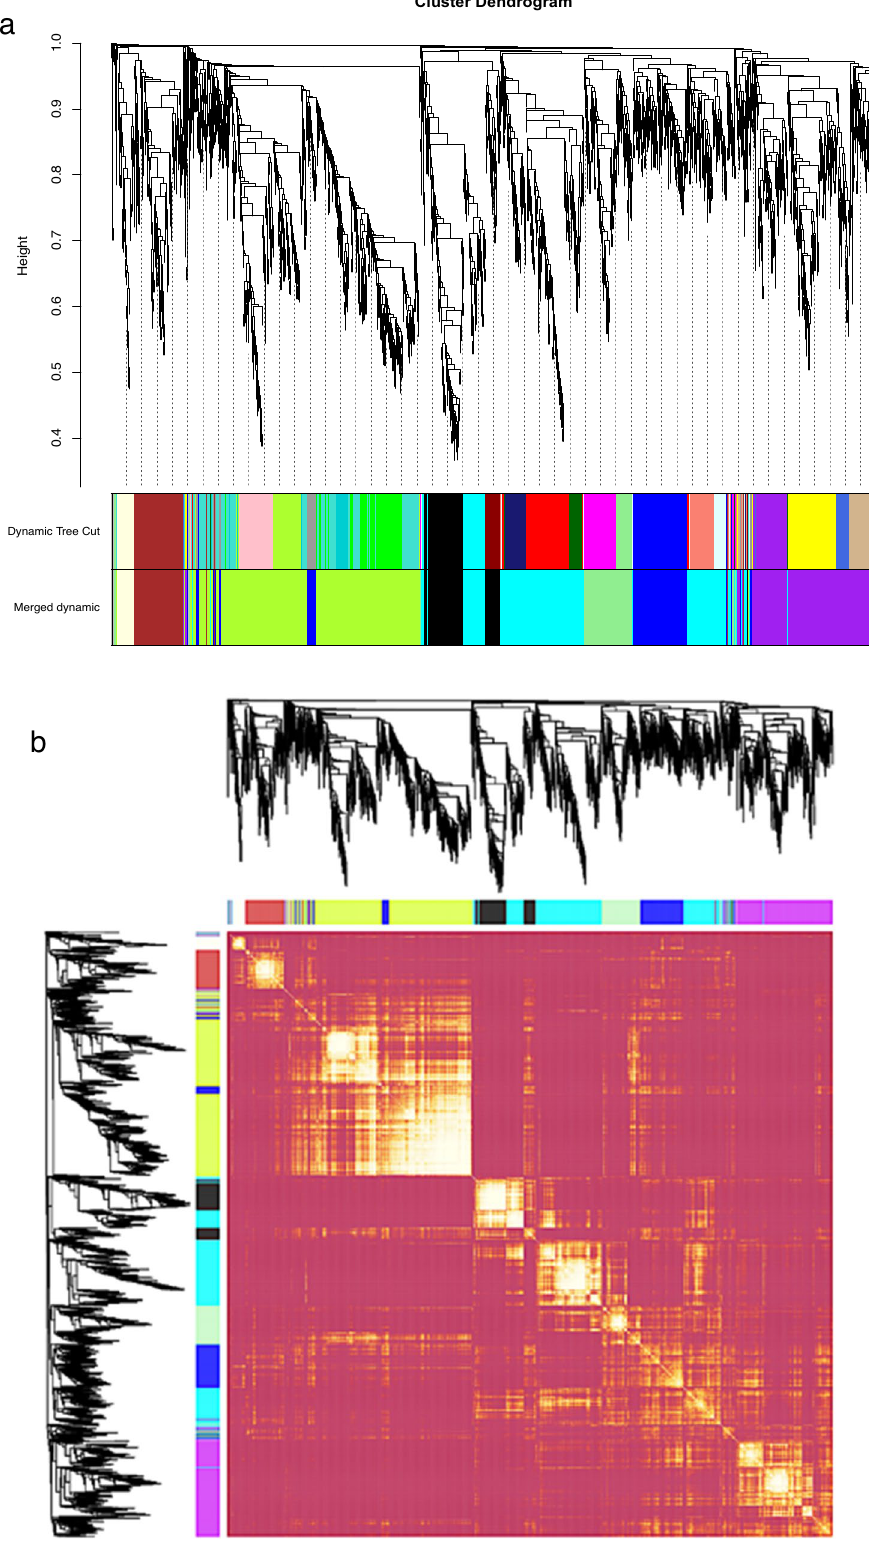
Figure 7. ( a ) Gene modules identified by WGCNA. Dendrogram was obtained by clustering dissimilarity with the modules represented by the colored block based on the topological overlap. A total of nine module (colored blocks) were identified where each module represents a set of highly connected genes. ( b ) Heatmap plot of the gene network. The heatmap depicts Topological Overlap Matrix (TOM) among all genes in the analysis. Light color represents overlap of highly expressed genes and the darker color represent low overlap of genes. Blocks of yellow colors along the diagonal are the